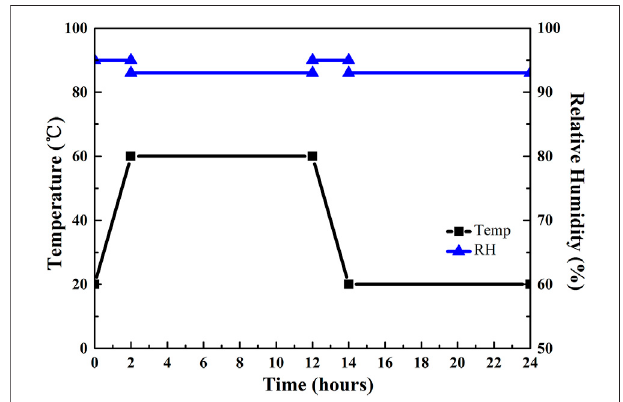
FIGURE 1 | Temperature and relative humidity fl uctuations under the combined hygrothermal